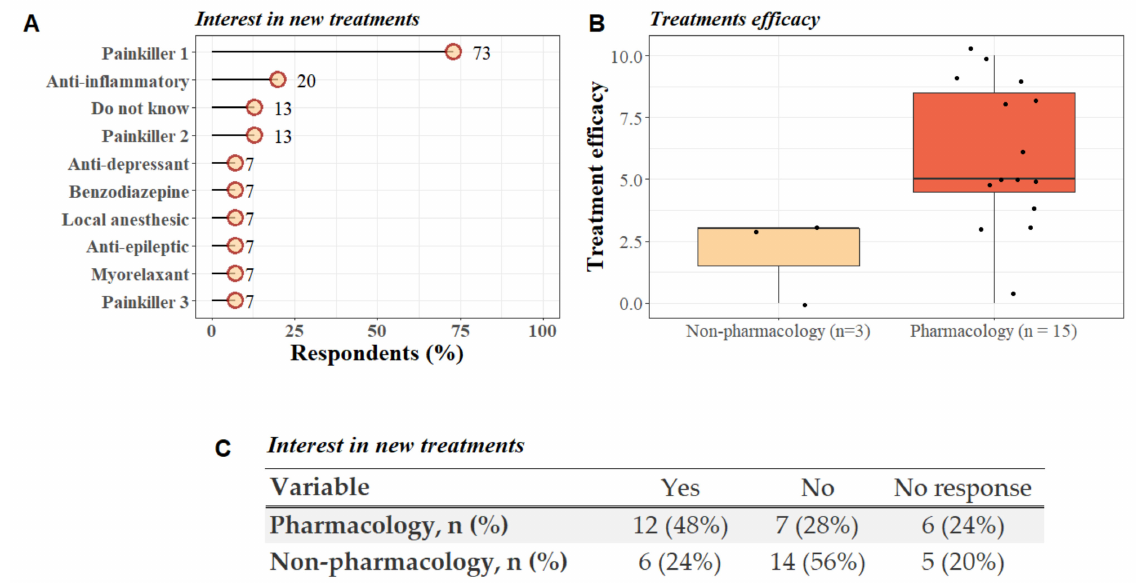
Figure 5. Pain treatment in LIS patients. ( A ) Lollipop plot representing the type of pharmacological treatments used by patients to treat pain (based on the WHO classification [27]). More than half of the patients used at least two types of medication (5/15; 53%). ( B ) Boxplot representing the treatments efficacy according to the participants opinion (0 = not effective, 10 = very efficient) and the type of treatments used (pharmacological vs. non-pharmacological). Additional information: only three out of 25 (12%) participants reported taking non-pharmacological treatments (osteopathy, acupuncture and electromagnetic therapy), among these three, two patients were also using pharma- cological treatments to manage pain. ( C ) Table shows the patients’ opinion about willing to try new pharmacological and/or non-pharmacological treatments to prevent